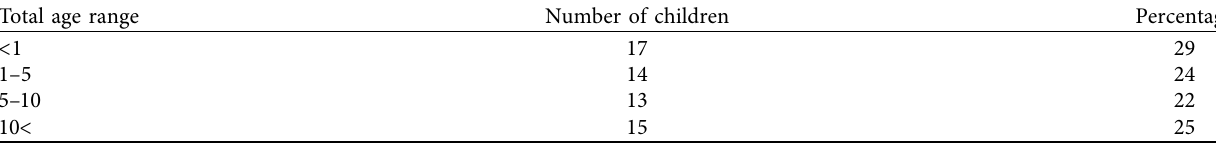
Table 1: Age groups of patients in total children.